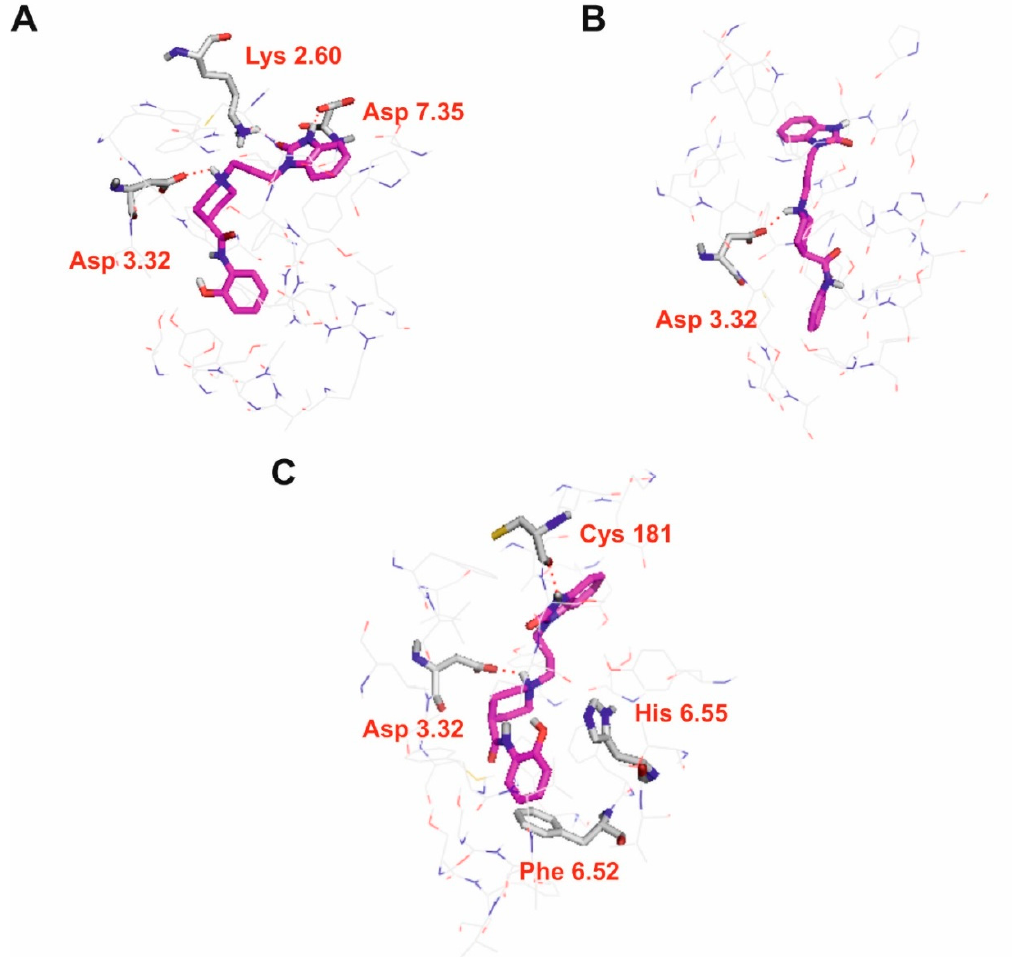
Figure 4. Molecular interactions of D2AAK4 with dopamine D 1 ( A ), D 2 ( B ) and D 3 ( C ) receptors. Ligands are represented as sticks with magenta carbon atoms. Protein represented as wire with grey carbon atoms, and main interacting residues are shown as sticks. Hydrogen bonds are shown as red dashed lines. Nonpolar hydrogen atoms not shown for clarity.